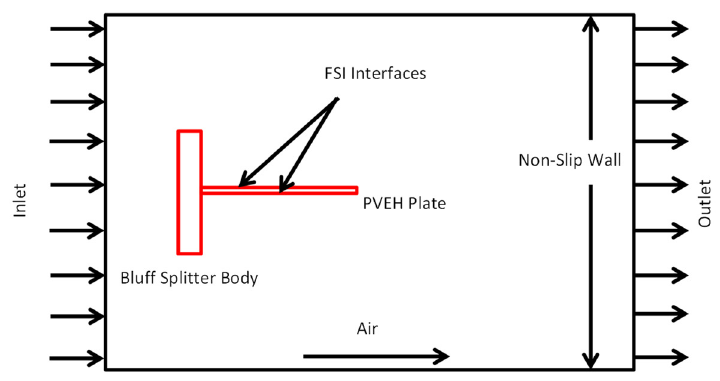
Figure 9. The 3D fluid domain simulation setup of coupled model of bluff splitter body and PVEH plate.